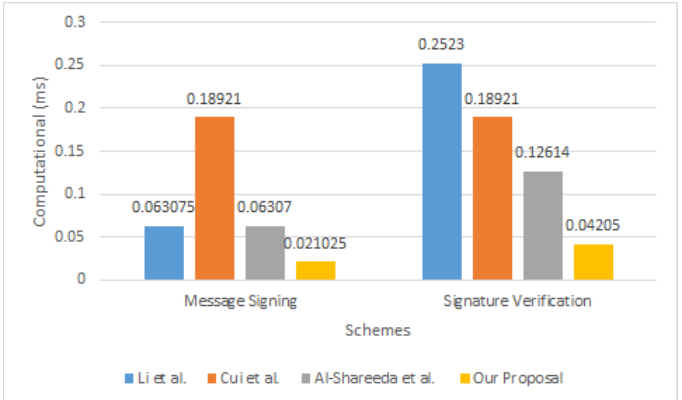
Figure 3. Comparison Computational Costs for Proposal and Other Schemes.